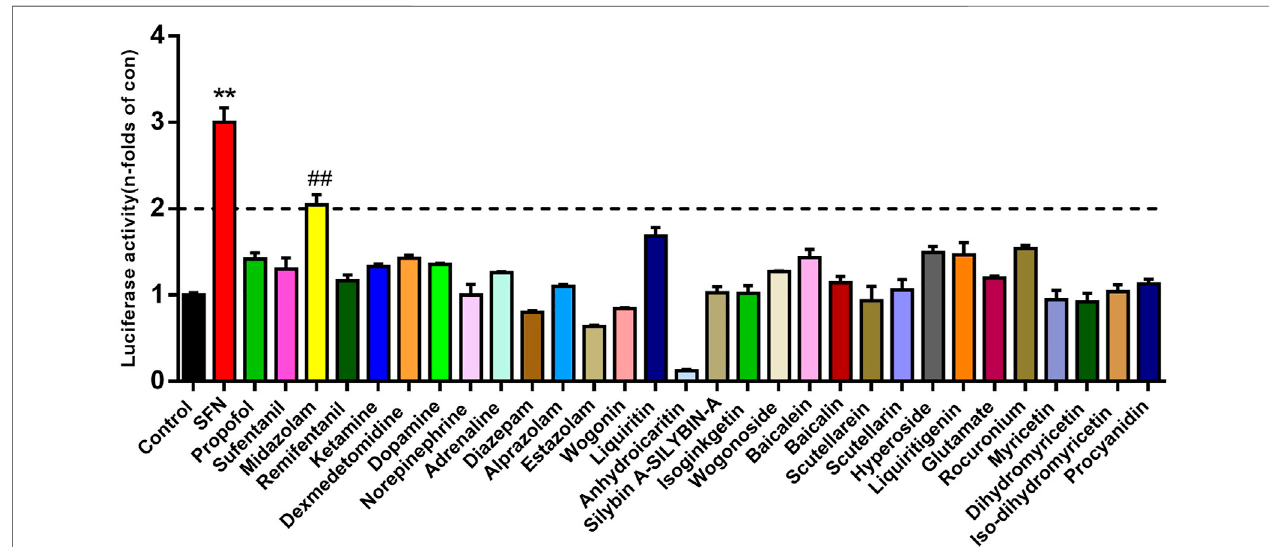
FIGURE 1 | The activation effects of different therapeutic drugs on Nrf2. Luciferase report assay analyzed the activity of Nrf2 in 293T-Nrf2-luc cells after 24 h treatmentwithdifferenttherapeuticagents (10 μ M, fi nalconcentration). Results werepresented asthemean±S.D.ofsixindependentexperiments. SFN,sulforaphane. The results were shown as mean ± S.D. ** p < 0.01 vs. the control group; ## p < 0.01 vs. the SFN group.